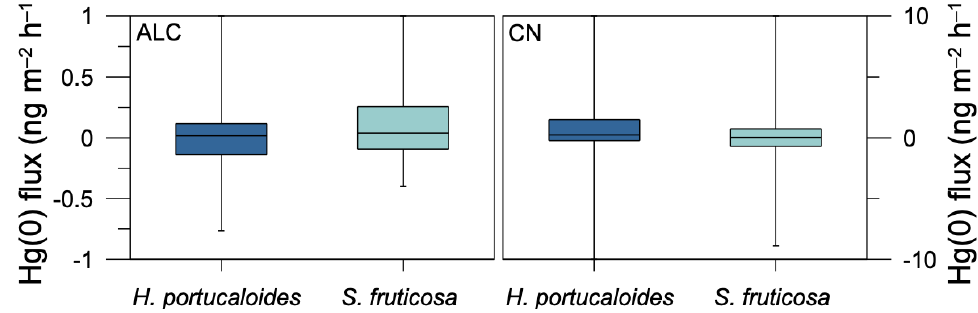
Figure 8. Vegetation–air Hg(0) fluxes (ng m −2 h −1 ) from Halimione portulacoides and Sarcocornia fruticosa in saltmarsh areas of the background site ALC and the industrial site CN.